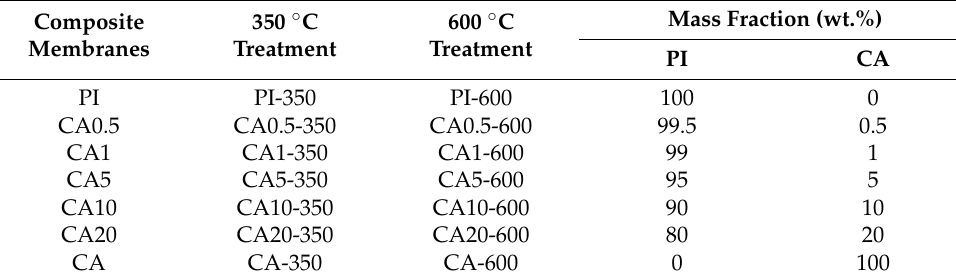
Table 1. List of sample compositions and